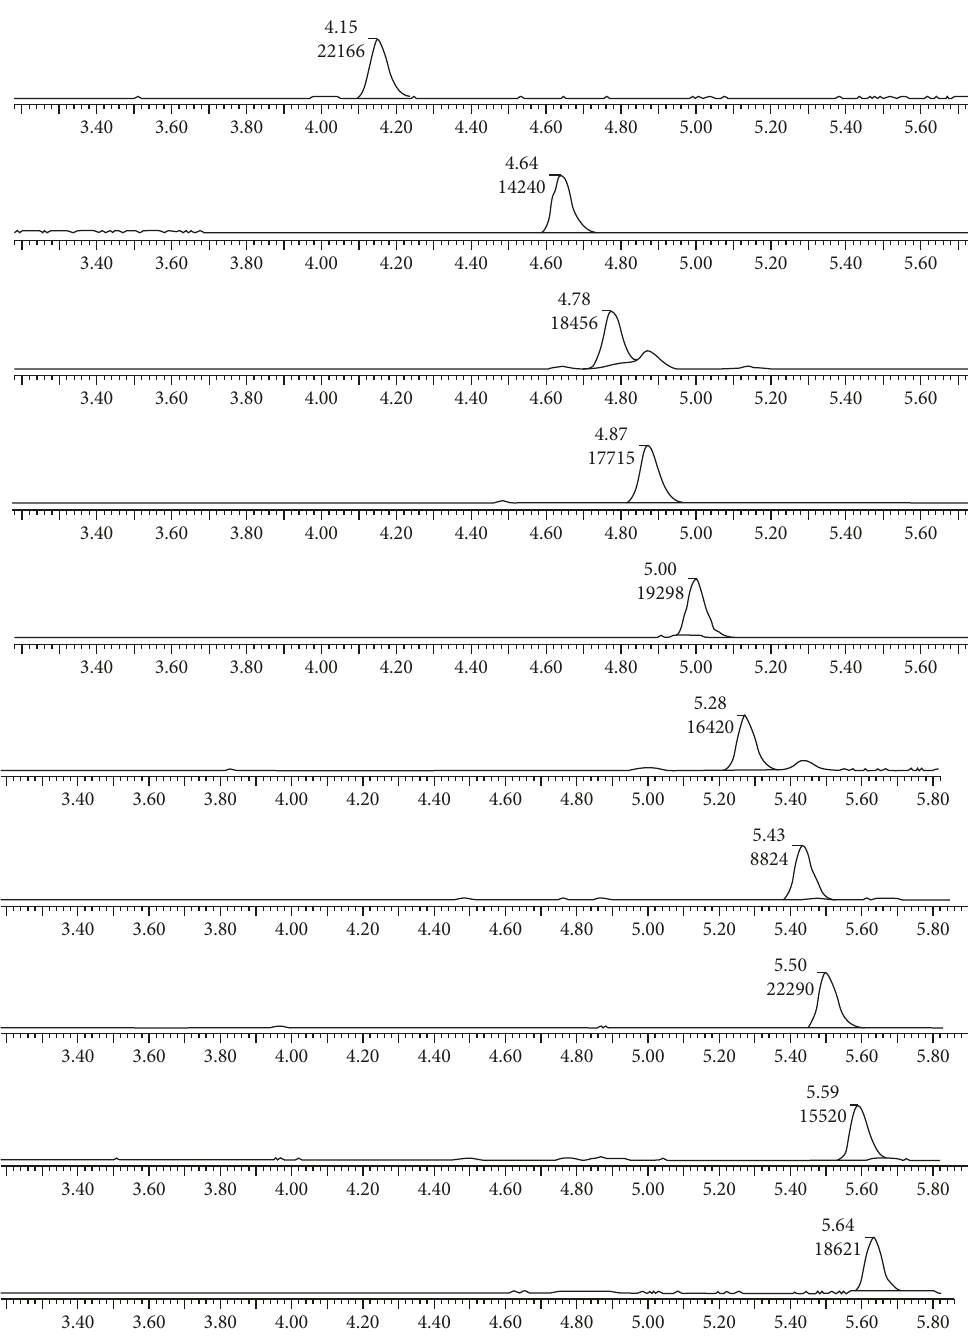
Figure 1: TOF mass spectrogram of 10 progestin standard